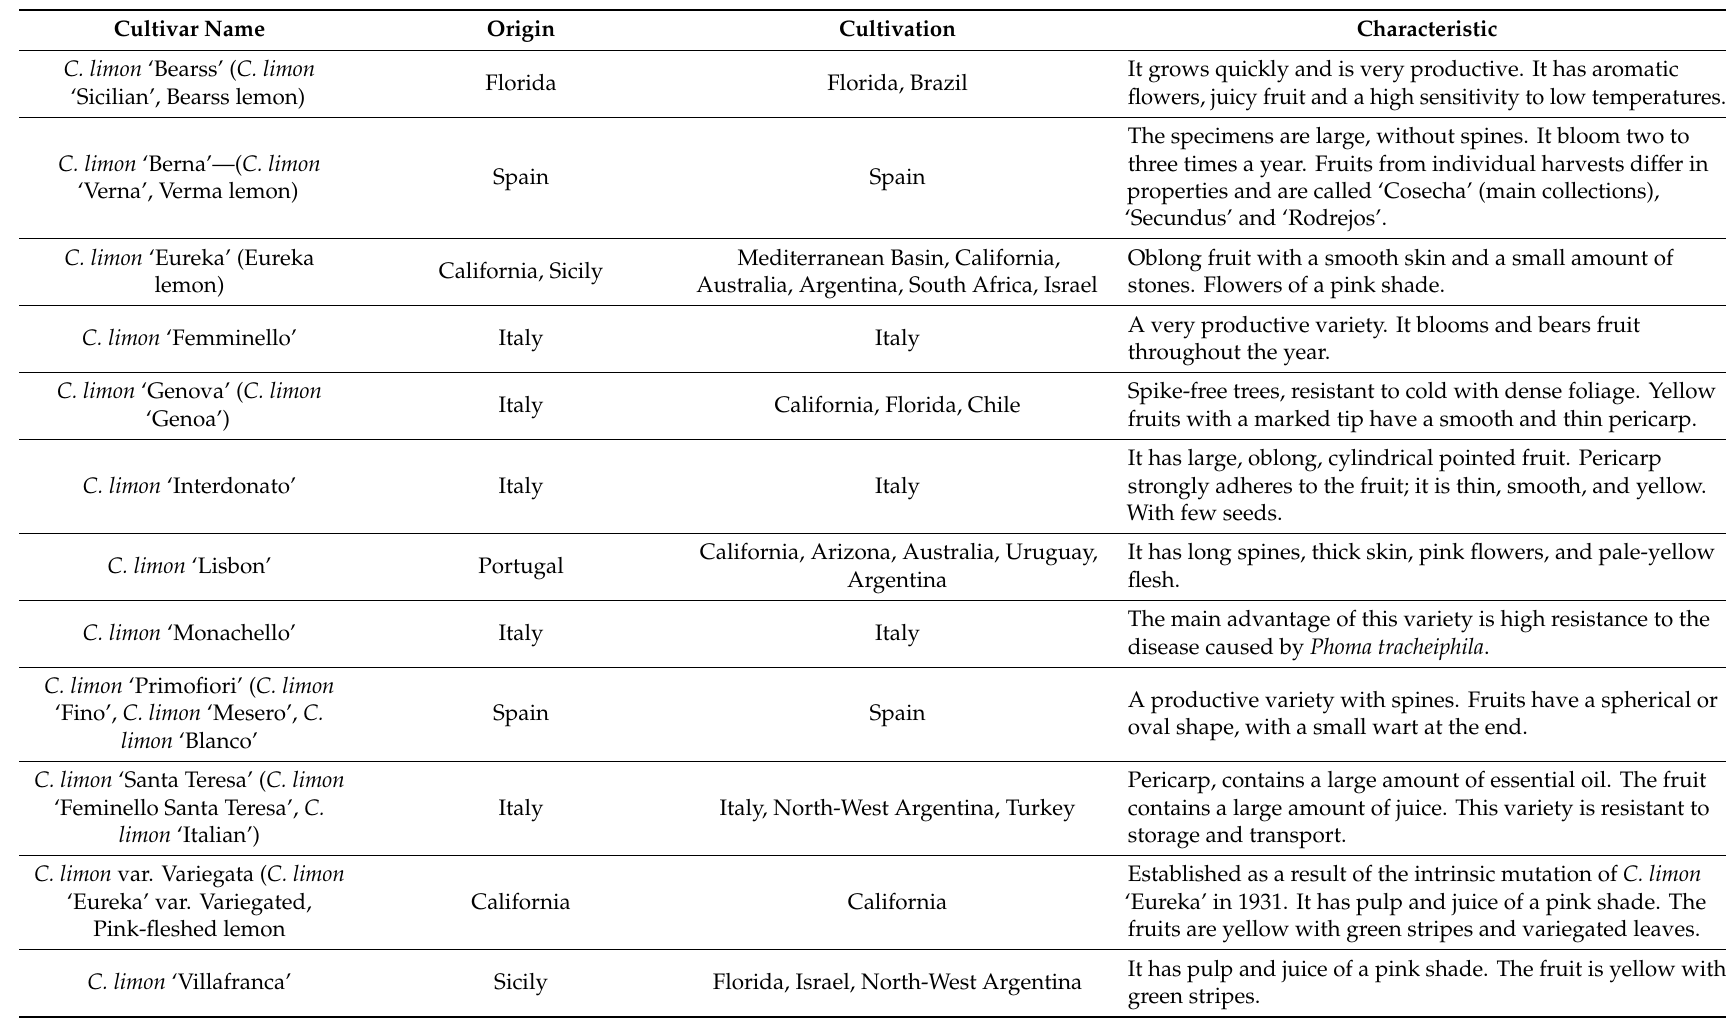
Table 1. C. limon